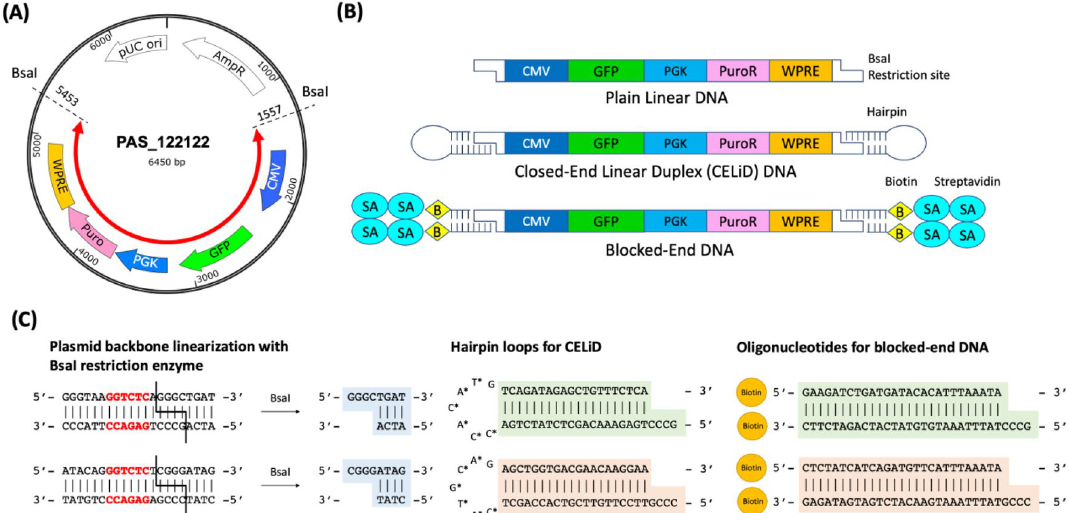
Figure 1. Design of DNA constructs used in this study. (A) Circular plasmid used as the common backbone for constructing various end-modified linear DNAs. The plasmid consisted of two constitutive expression cassettes for the GFP reporter and puromycin resistant selection marker, in addition to the WPRE element, flanked by the two BsaI restriction sites. The red arrow indicates a portion of the plasmid corresponding to the linear DNAs. (B) Structure of the linear DNAs. The end regions of the CELiD consisted of closed hairpin loop structures. The ends of blocked-end DNA contained biotin-labeled oligonucleotides, which were further non-covalently bound to streptavidin tetramers. (C) Detailed sequences of the sticky ends created by the plasmid backbone linearization by the BsaI restriction enzyme, as well as the hairpin loops and oligonucleotides complementary to each end. Starred bases indicate positions of phosphorothioate linkages on the 5’